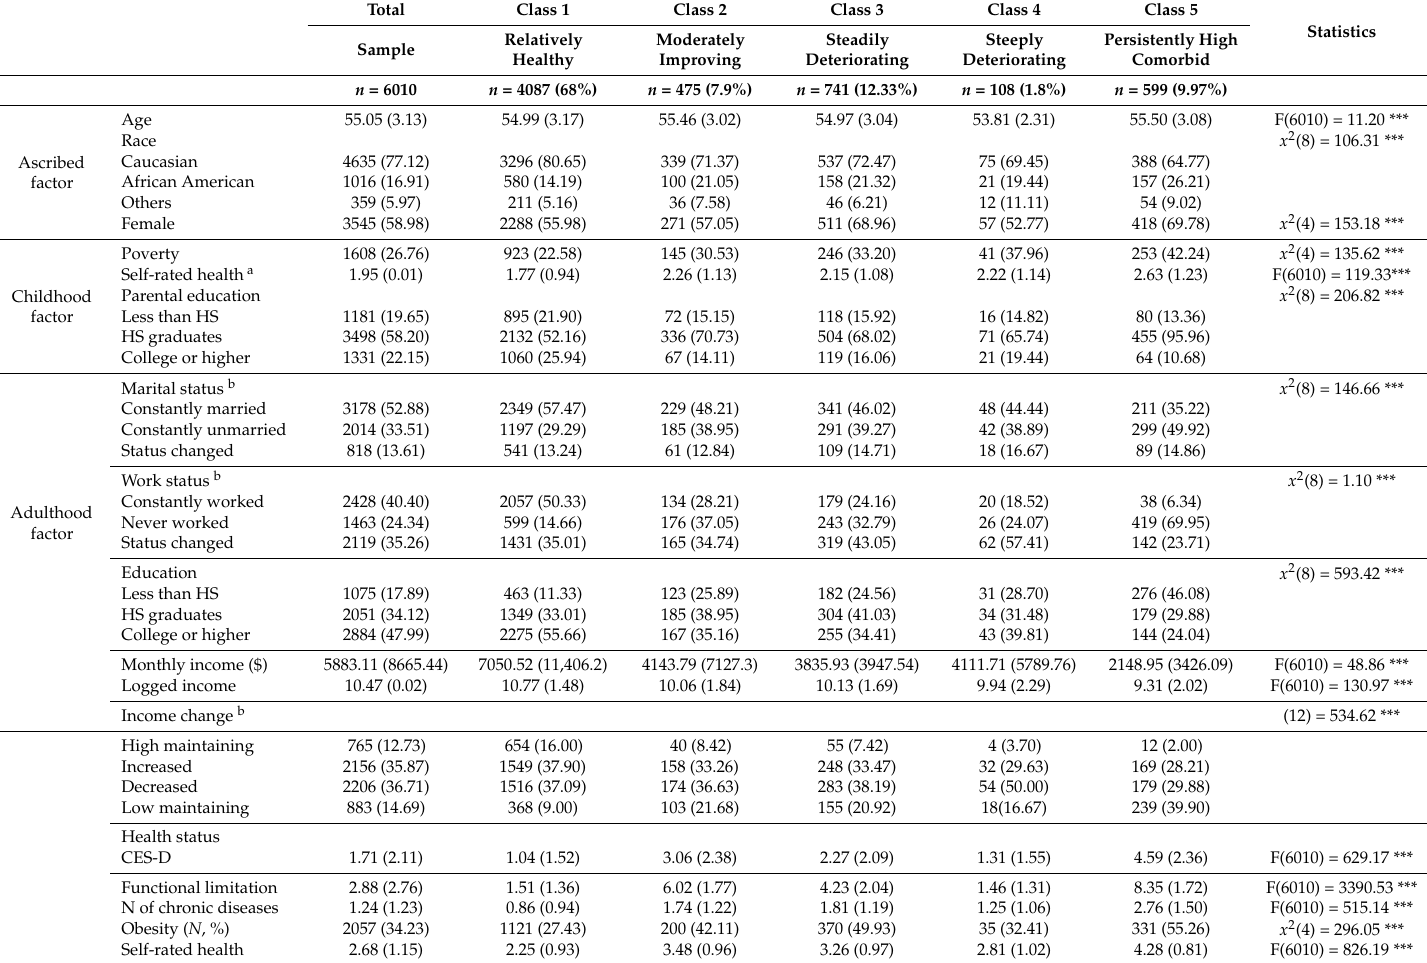
Table 2. Baseline characteristics of trajectory groups (mean (standard deviation), or n